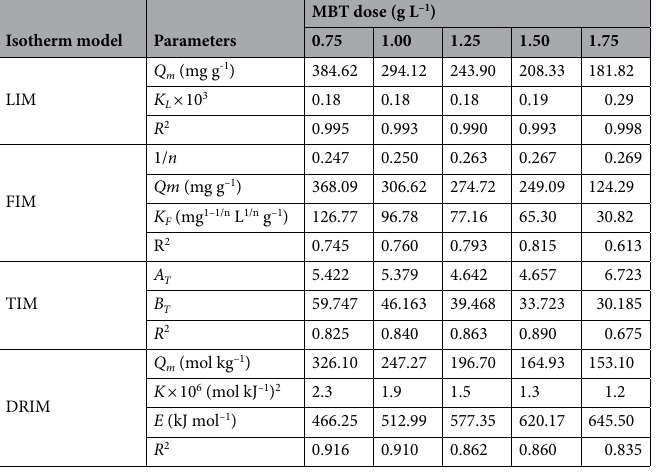
Table 1. Data from an isotherm investigation of AY11 dye adsorption using MBT [AY11 dye starting concentration (100–400 mg L –1 ), MBT dose (0.75–1.75 g L –1 ), and RT (24 ± 2